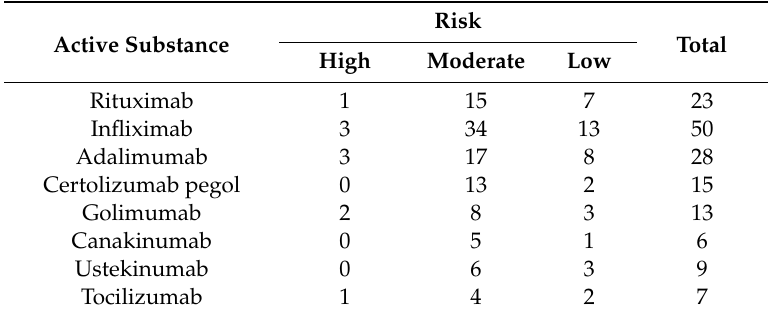
Table 2. Changes authorised by European public assessment report (EPAR) in the production of monoclonal antibodies (mAbs) for rheumatic diseases [67].